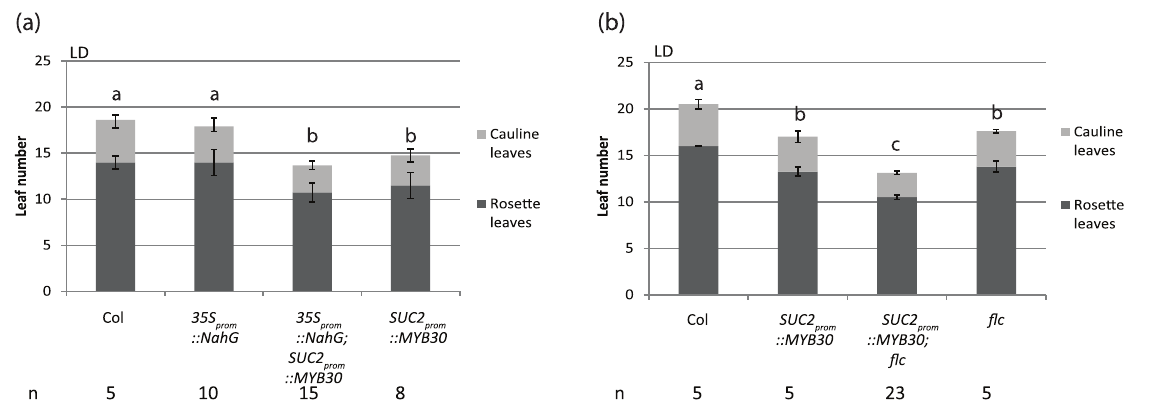
Figure 7. SUC2 prom ::MYB30 promotes flowering independently of SA and FLC. ( a ) Flowering time measurement of Col , NahG , SUC2 prom ::MYB30 and NahG;SUC2 prom ::MYB30 under LD conditions. ( b ) Flowering time measurement of Col, SUC2 prom ::MYB30 , flc and SUC2 prom ::MYB30;flc under LD conditions . Statistical significance was determent using one way Analysis of Variance (ANOVA) followed by multiple comparison with the Holm-Sidak procedure (p , 0.01). Significant differences are indicated by different letters above the bars. The number of plants for each genotype (n) is indicated below the graph.